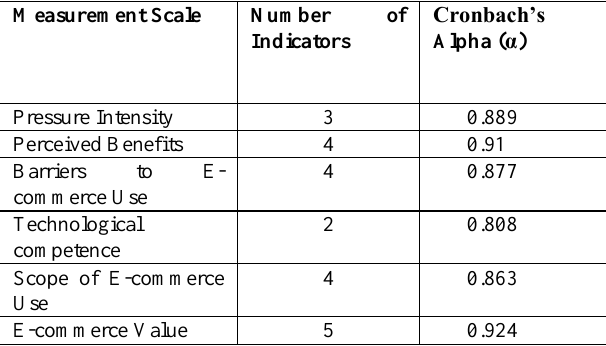
Table 2: Reliability of constructs (Cronbach’s Alpha) Measurement Scale